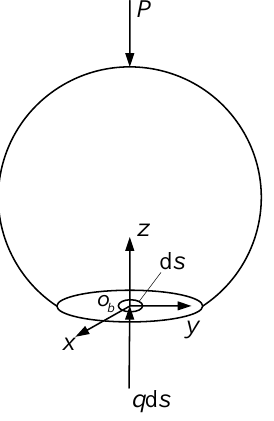
Figure 3. Force element qds acting normal to the circular contact area of the sphere.